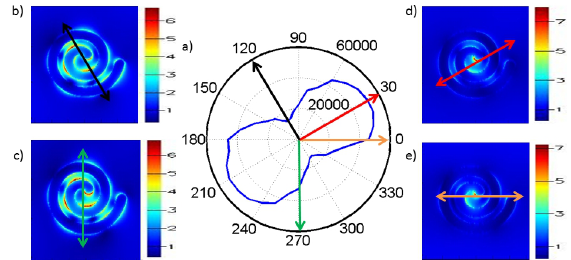
Figure 2: a) SHG response to the axis of a linearly polarized exci- tation. 0 degrees corresponds to the line drawn between the be- ginning and end of the spiral (orange arrow). Maximum SHG signal occurs at 30 degrees (red arrow). Minimum SHG signal occurs at 120 degrees (black arrow). b–e) FDTD simulations of the